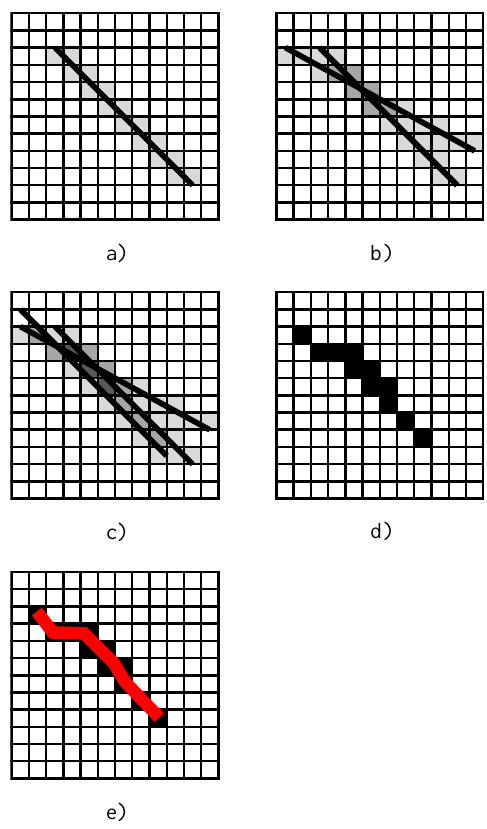
Figure 2. Workflow of the raster-based integration